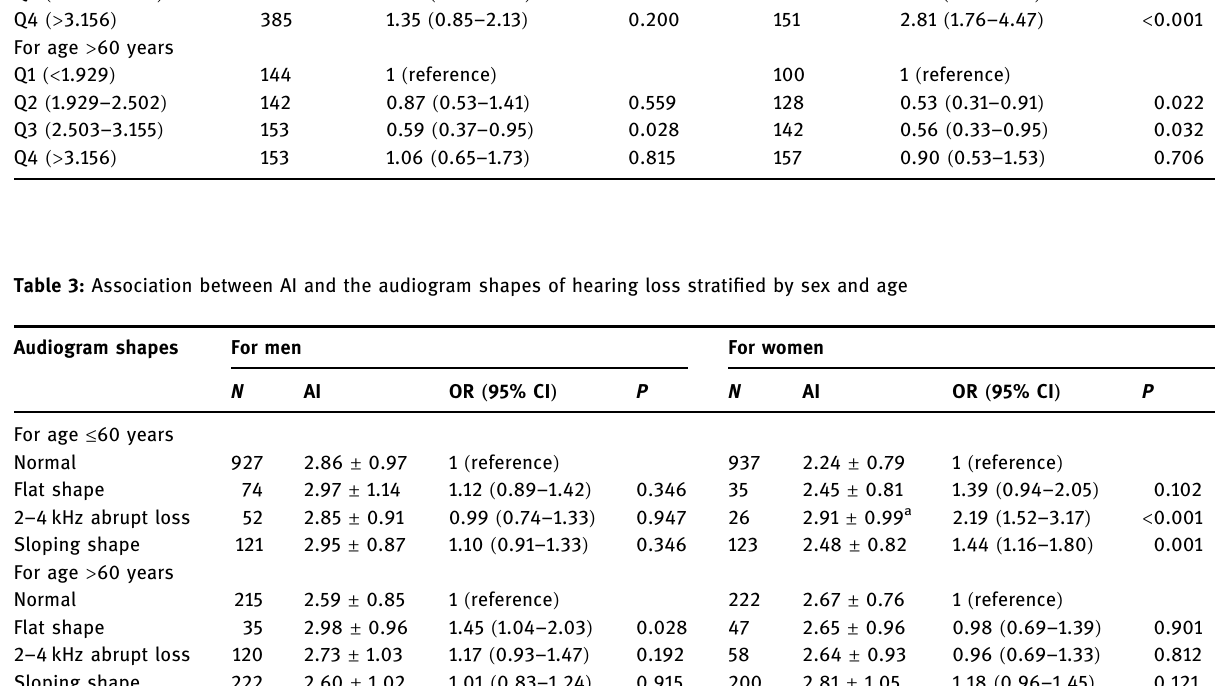
For age > 60 years